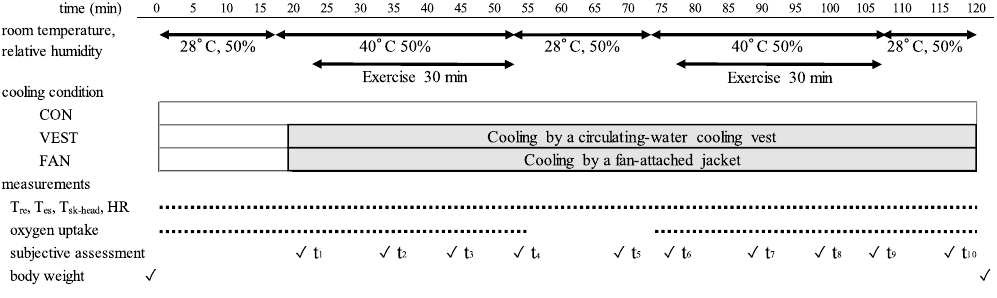
Figure 1. Schematic of the testing protocol. CON: participants did not wear any cooling garment, VEST: participants wore a circulating-water cooling vest, FAN: participants wore a fan-attached jacket, T re : rectal temperatures, T es : esophageal temperatures, T sk-head : skin temperatures of the frontal head, HR: heart rate. t 1 and